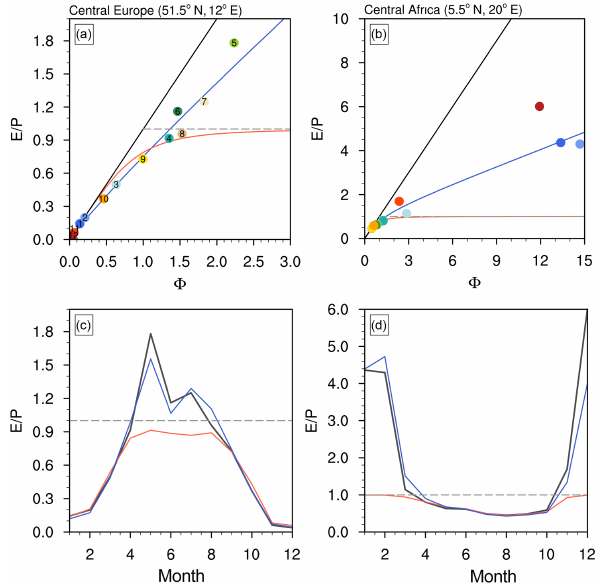
Figure 9. Data cloud of monthly climatologies within the Budyko space for a grid points in (a) central Europe (51.5 ◦ N, 12 ◦ E) and (b) central Africa (5.5 ◦ N, 20 ◦ E). The black solid line denotes the demand limit; the dashed line denotes the original supply limit. The blue line depicts the obtained curve using the modified formulation of Fu’s equation, whereas the red line shows the original Fu curve. Numbers within the dots denote the particular month of the year. (c, d) Observed (grey) and computed mean seasonal cycles at both grid points. The blue line depicts the obtained seasonal cycle us- ing the modified formulation of Fu’s equation, whereas the red line shows the seasonal cycle obtained using Fu’s equation. Please note that axes are different in each